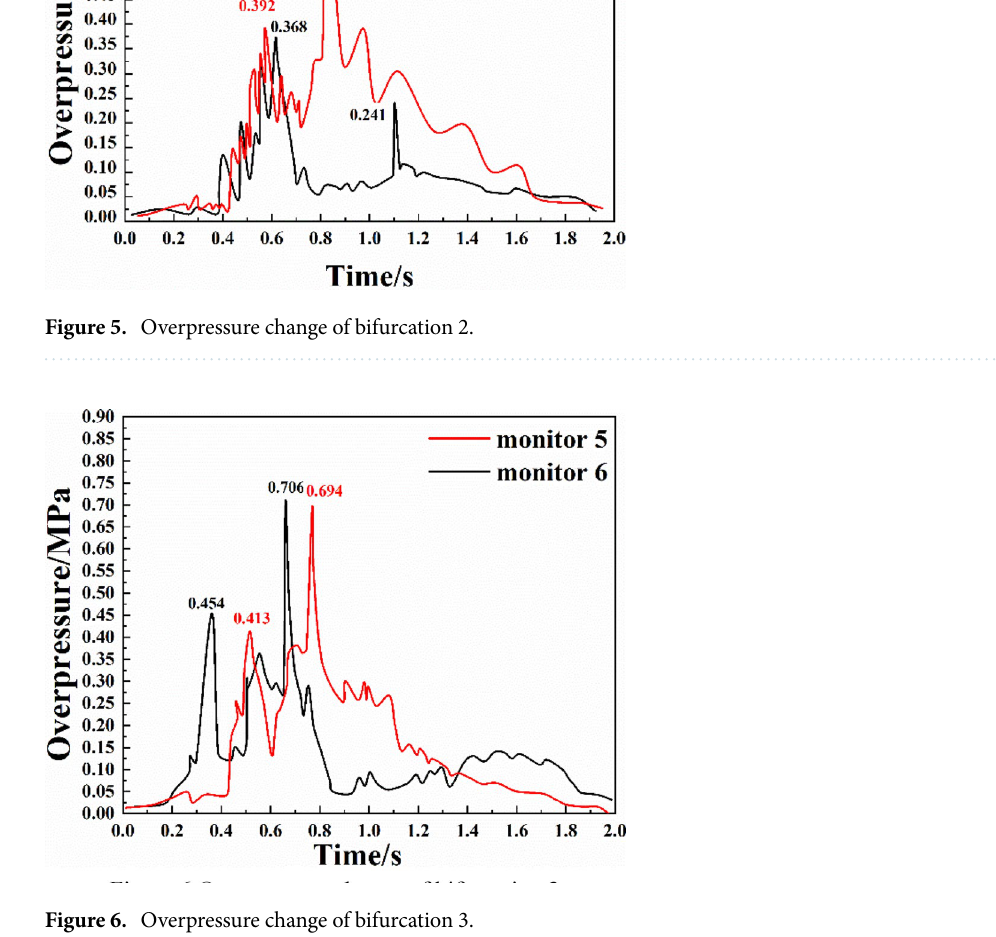
Figure 6. Overpressure change of bifurcation